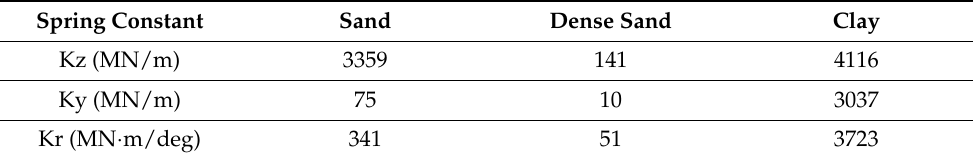
Table 2 lists the calculated soil stiffnesses. Table 2. Soil stiffness according to soil